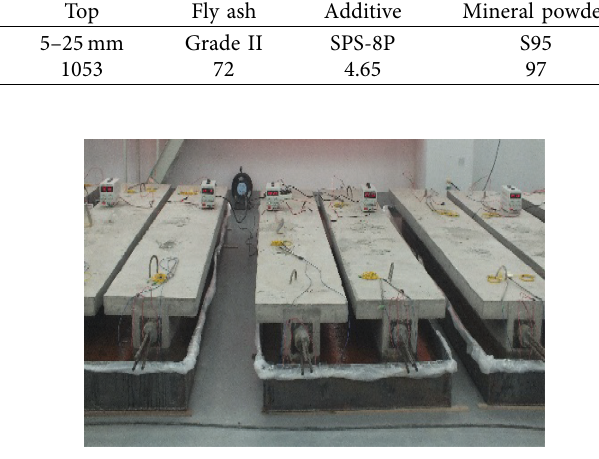
Figure 7: Electric corrosion.